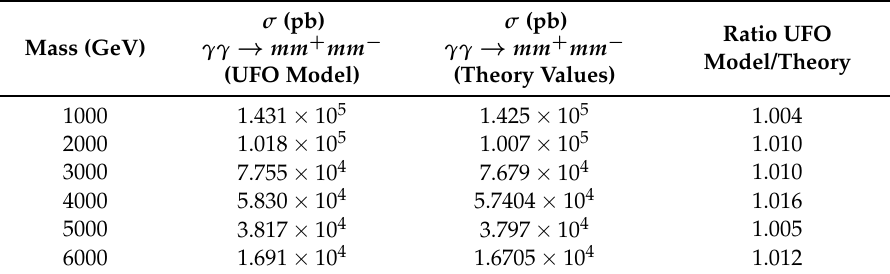
Table 3. The cross-section for the spin 1 / 2 monopole as obtained by the theory and the M AD G RAPH UFO model for the β -independent coupling when no PDF is used and the center-of-mass energy is 13 TeV. The fourth column shows the ratio of the cross-sections of the UFO model to that of the theoretical prediction. As the ratios are very close to 1, this suggests excellent agreement between the theory and the M AD G RAPH model [10].